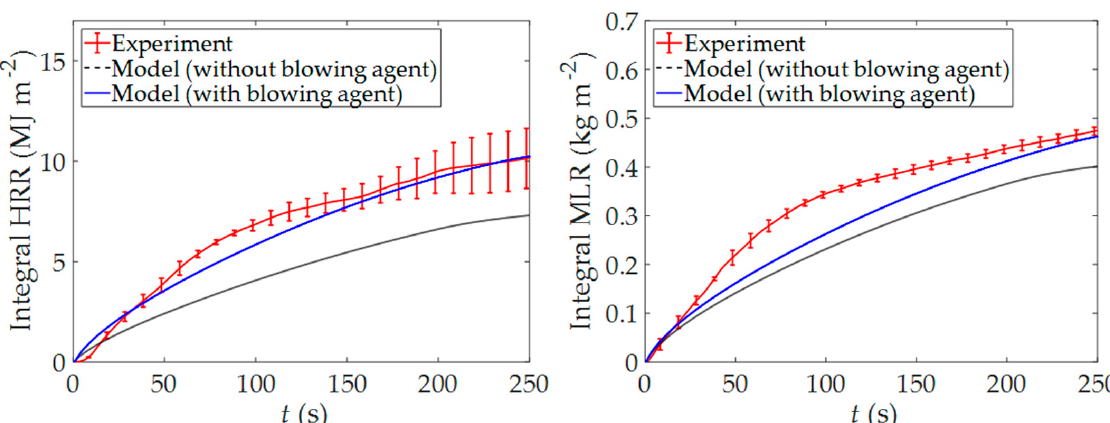
Figure 6. Mean experimental results and model predictions for the cone calorimetry tests performed on the PIR foam at 50 kW m − 2 of set radiant heat flux.